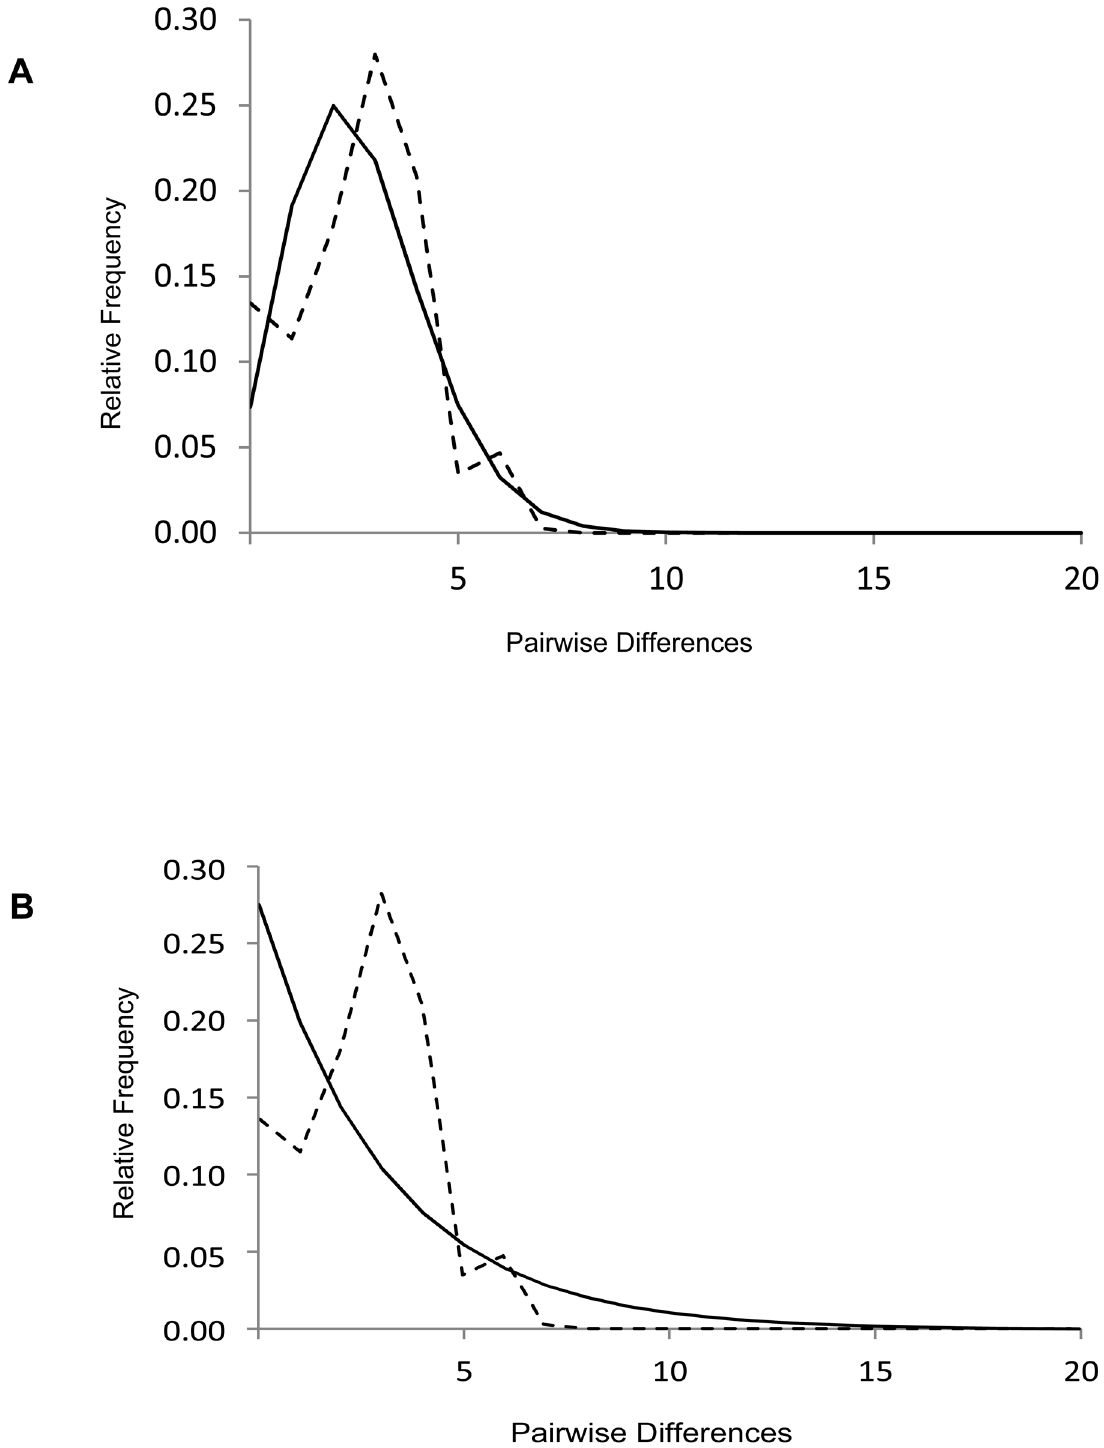
Fig 5. Mismatch distributions of pairwise differences of CR haplotypes for the golden jackal in India. Depicted are observed (dashed lines) and expected (solid lines) frequencies obtained under a model allowing (A) and not allowing for demographic expansion (B).